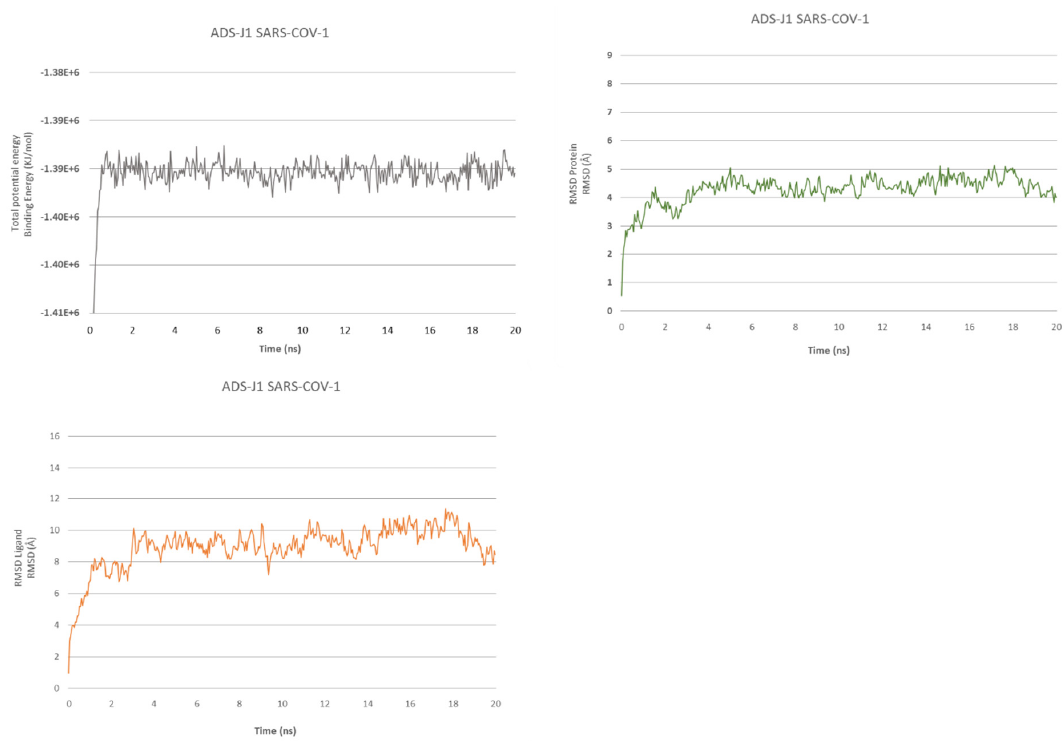
Figure 1. ADS-J1@SARS-CoV-1 fusion core. Total energy ( upper left ), RMSDs ( upper right ) of protein and RMSDs ligand ( lower left ).